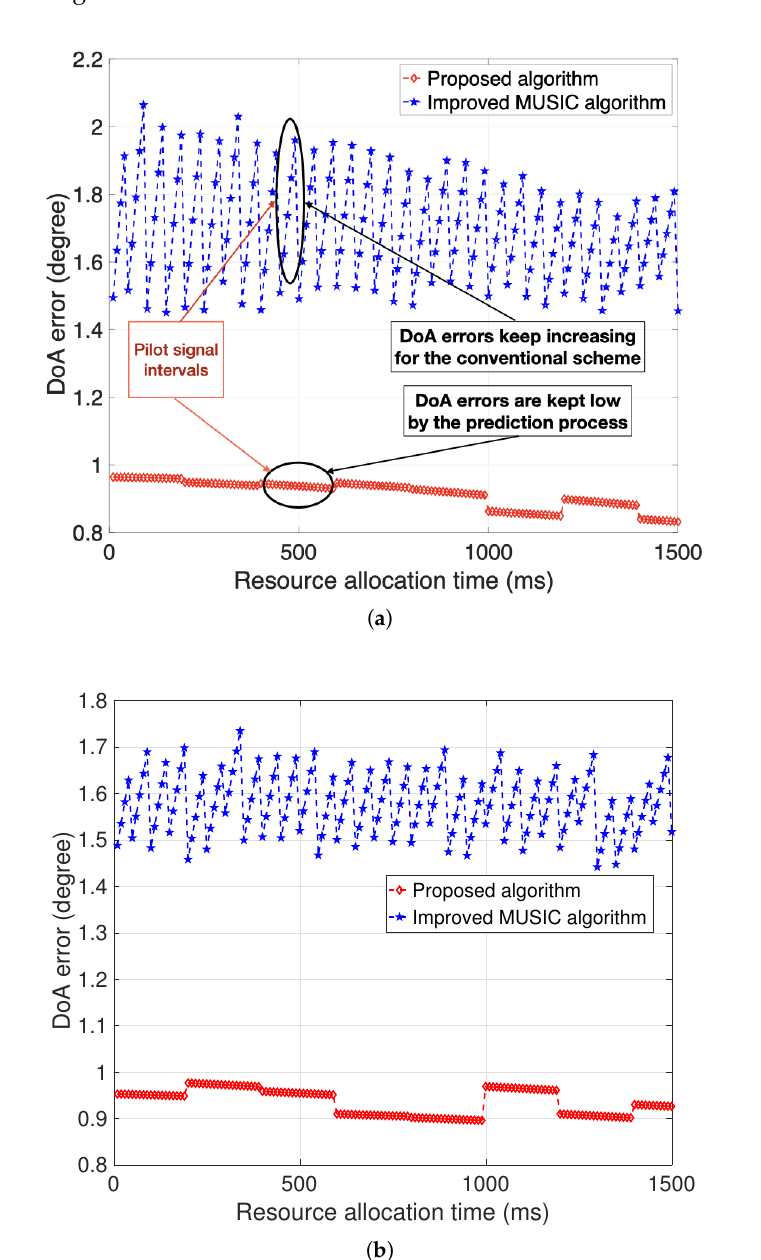
Figure 5. DoA estimation errors of the proposed and the improved MUSIC algorithms. ( a ) The UAV speed is 160 km/h. ( b ) The UAV speed is 60